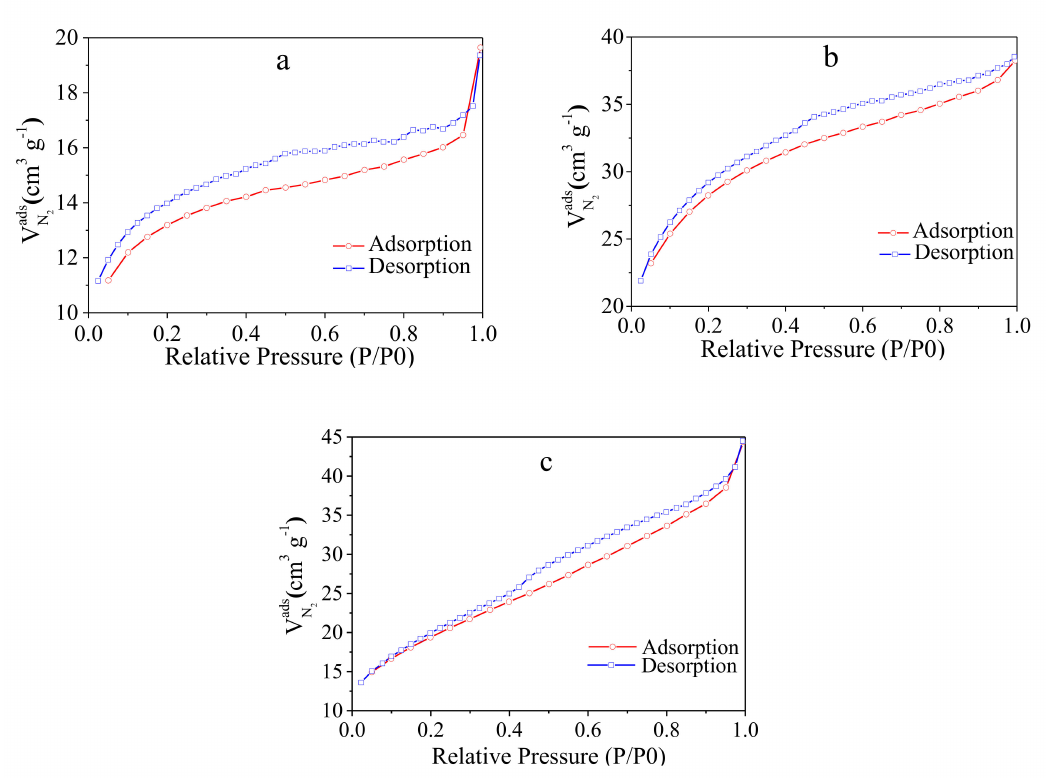
Figure 4. N 2 sorption measurements of: ( a ) 1200 ◦ C (C-5); ( b ) 1300 ◦ C (C-10); ( c ) 1400 ◦ C (C-15) samples.